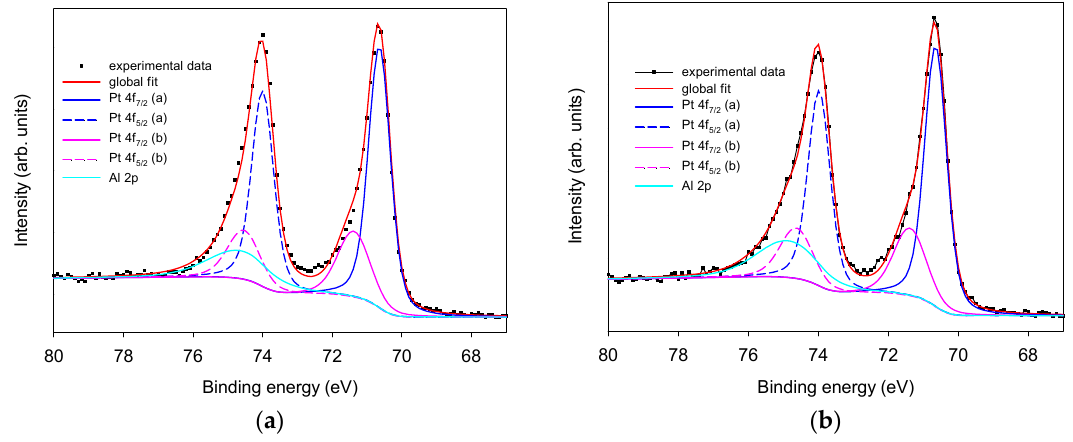
Figure 3. XPS high-resolution region of Pt 4f and Al 2p. Panel ( a ): untreated Pt SPE; panel ( b ): phosphate buffer 0.1 M LIFT treated Pt SPE.